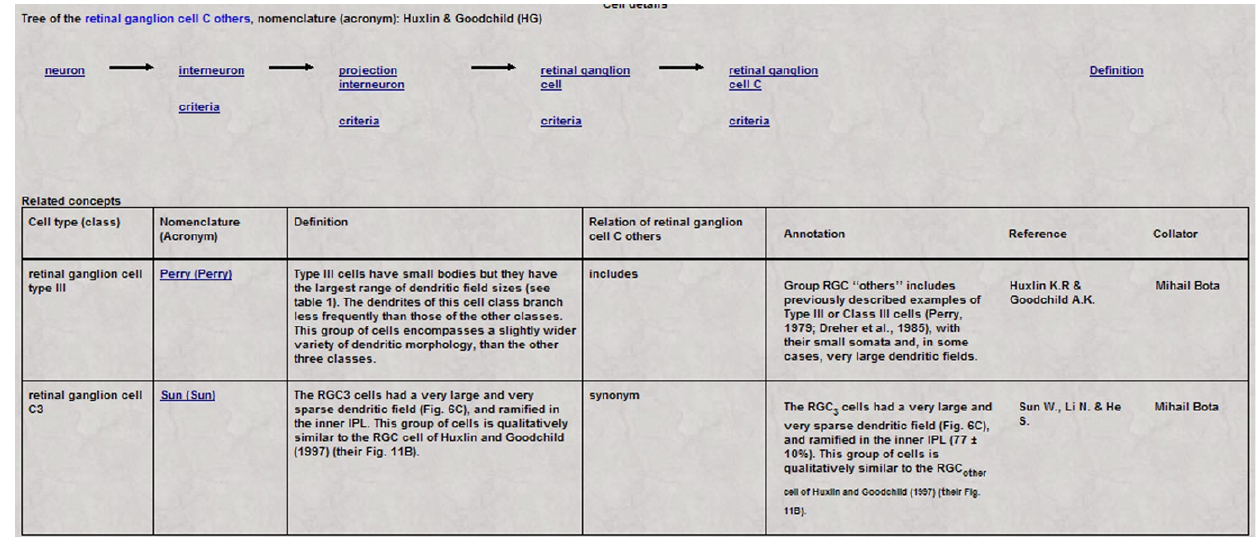
Figure 6. Information that can be retrieved in BAMS and is related to neuron concepts include related terms, their semantic relations, annotations, references and collators, as well as the set of parents with links to the associated classifi cation criteria. The neuron type “C others” defi ned in the nomenclature “Huxlin & Goodchild” (Huxlin and Goodchild, 1997) has two related terms in BAMS Neuroanatomical Ontology: it includes the retinal ganglion cell type III, nomenclature Perry (Perry, 1979) and has as synonym the retinal ganglion cell C3, nomenclature Sun (Sun et al., 2004).